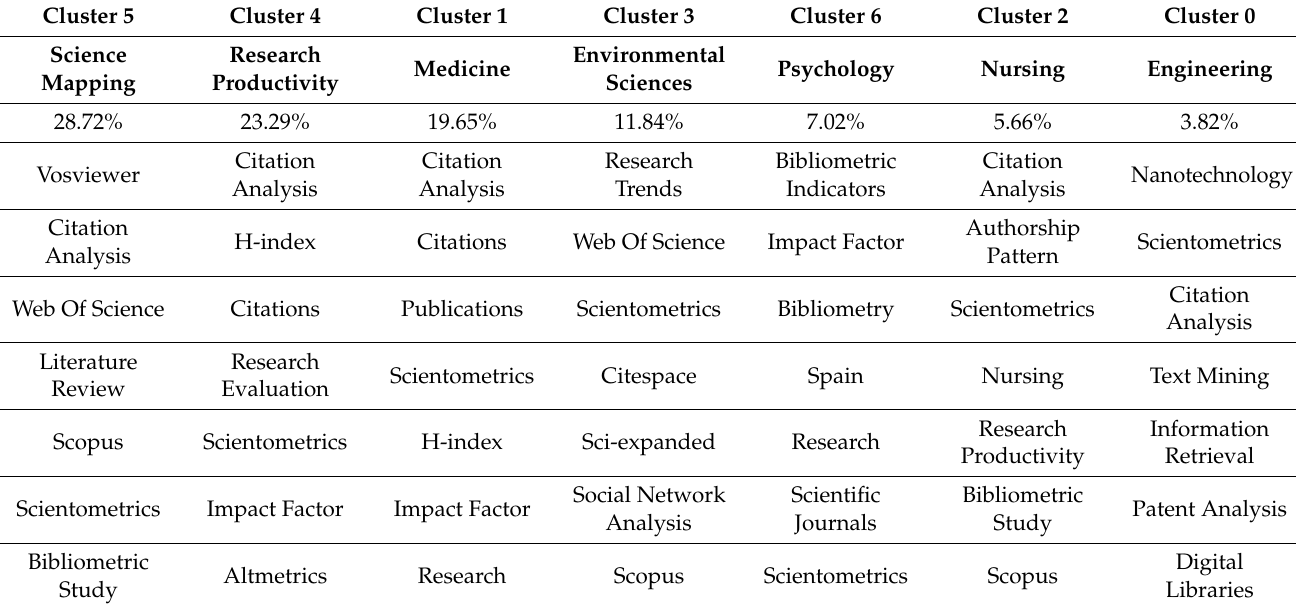
Table 17. Main keywords of each